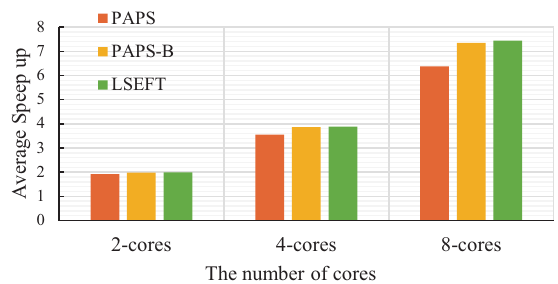
Figure 7. Average speed up with different scheduling